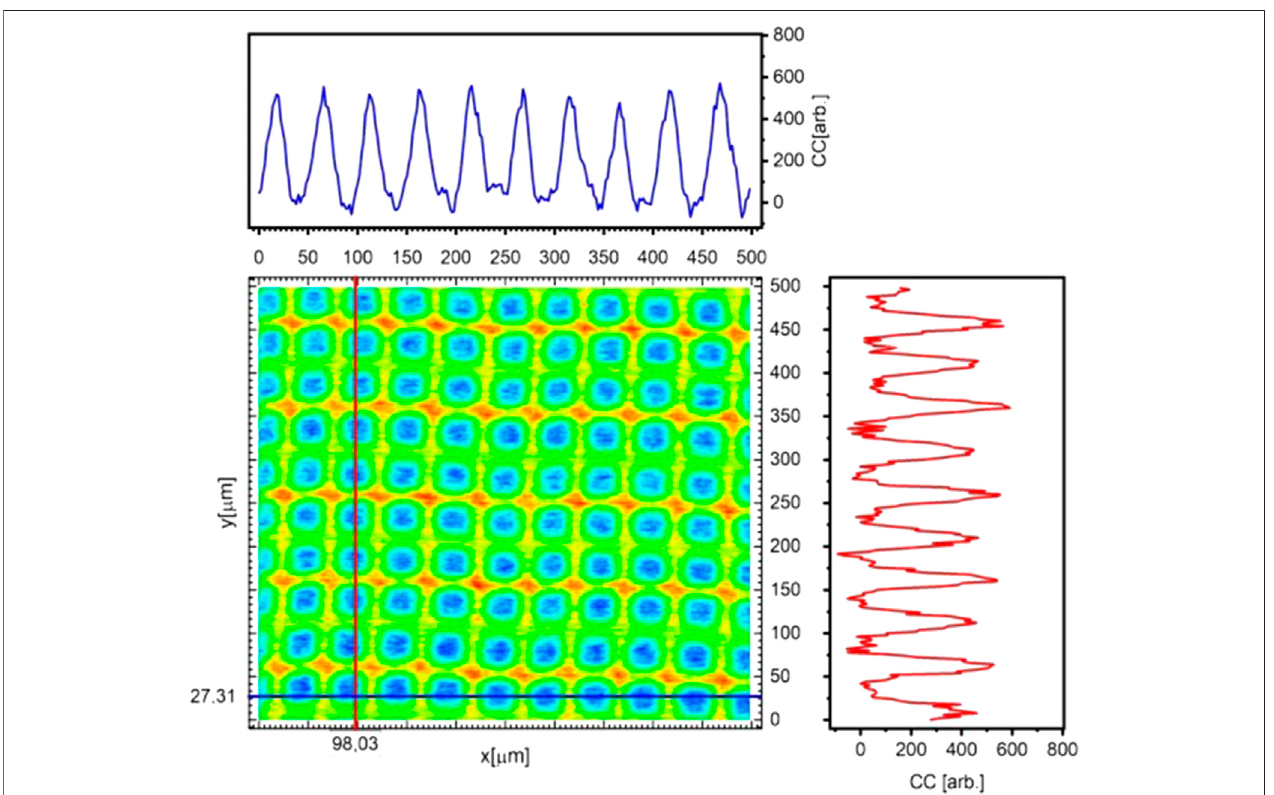
FIGURE 9 | Am-241 spectrum of an AC-coupled pixel sensor attached to PSI46dig ROC by fl ip-chip bonding.